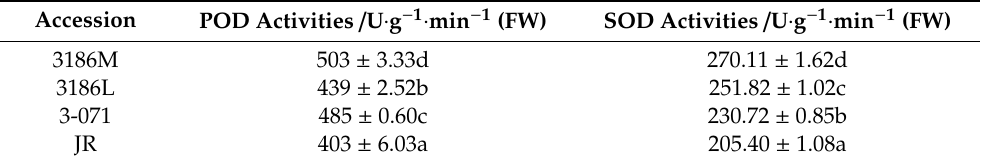
Figure 7. ( A ) Disease index of tomatoes with di ff erent trichome types at di ff erent time points after being inoculated with Botrytis cinerea . ( B ) Changes in the SOD activity of di ff erent tomato varieties 1 week after being inoculated with Botrytis cinerea . ( C ) Changes in the POD activity of the di ff erent tomato varieties 1 week after being inoculated with Botrytis cinerea . The content of SOD and POD were measured as previously reported [24]. The data represent the means of three replicates ± SD. All experiments were repeated three times with similar results. Table 1. Peroxidase (POD) and Superoxide dismutase (SOD) activities in tomato seedlings that were sprayed with Botrytis cinerea at the five-leaf stage. The activities were measured one week after spraying. Among them, a, b, c, and d represent di ff erent degrees of POD and SOD activities. The values represent the average of three technical replicates ± SD. 3186M (tomato wo mutant, hairy), 3186L (tomato wo mutant, hairless), 3-071 (tomato ln mutant, hairless), JR (tomato cultivar Jia Ren).